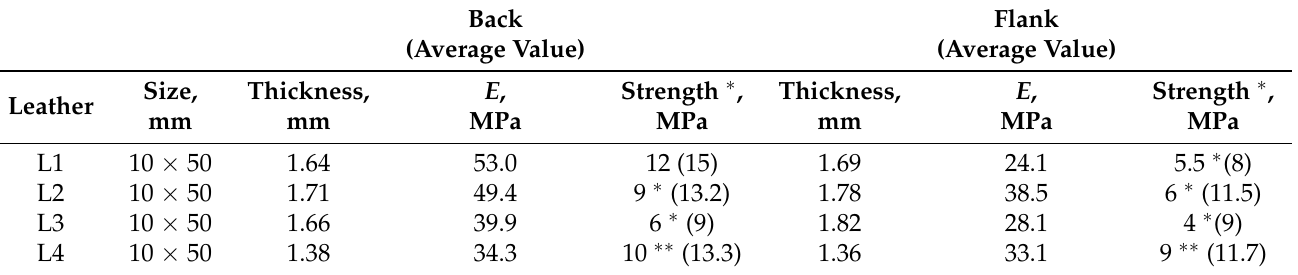
Table 3. Tensile test data of leather